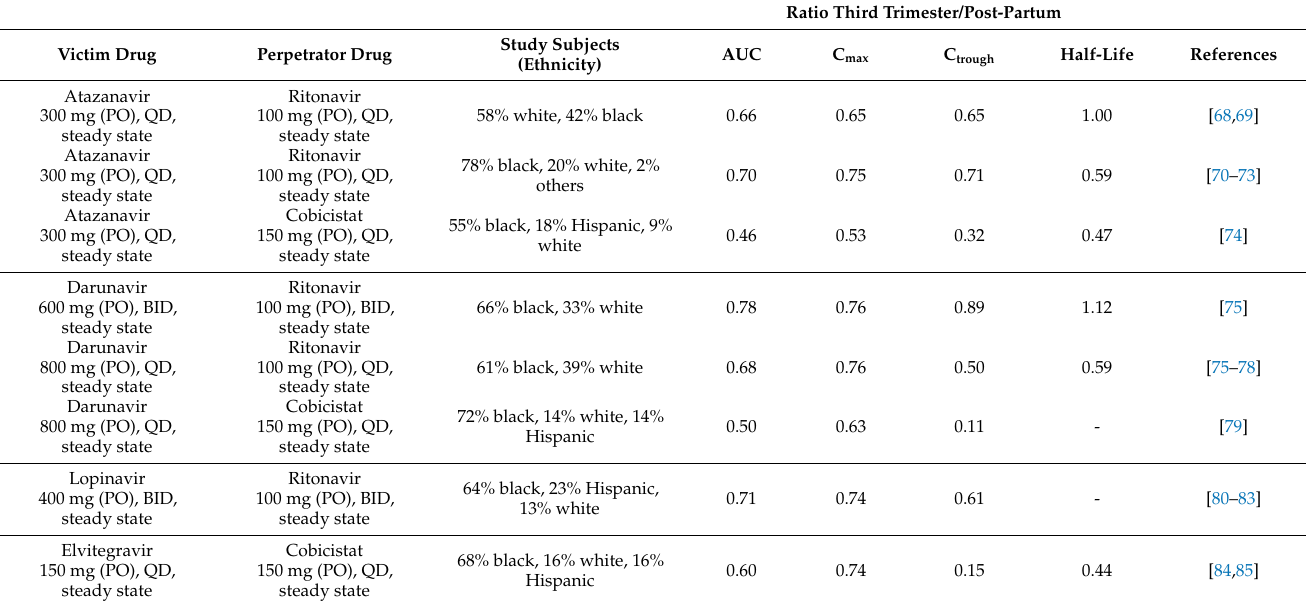
Table 8. Comparison of DDI magnitudes with inhibitors impacting drug metabolism in pregnant women relative to non-pregnant